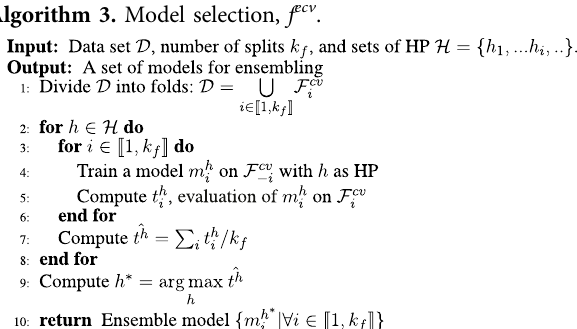
Algorithm 3. Model selection, f ecv .